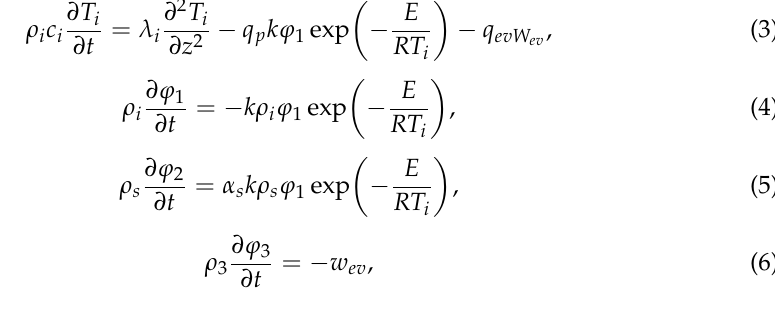
Figure 2. Scheme of the problem. During numerical simulation, the one-dimensional heat equation and kinetic equation were